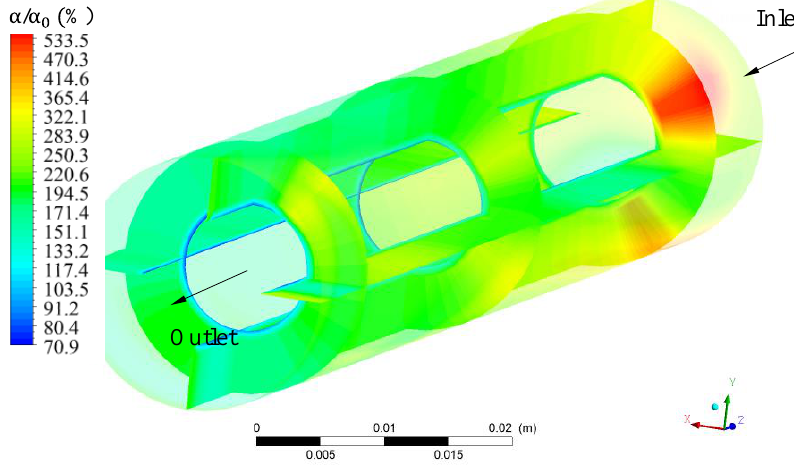
Figure 6. Relative oil volumetric fraction distribution at different regions of membrane 1 during the water/oil separation process.